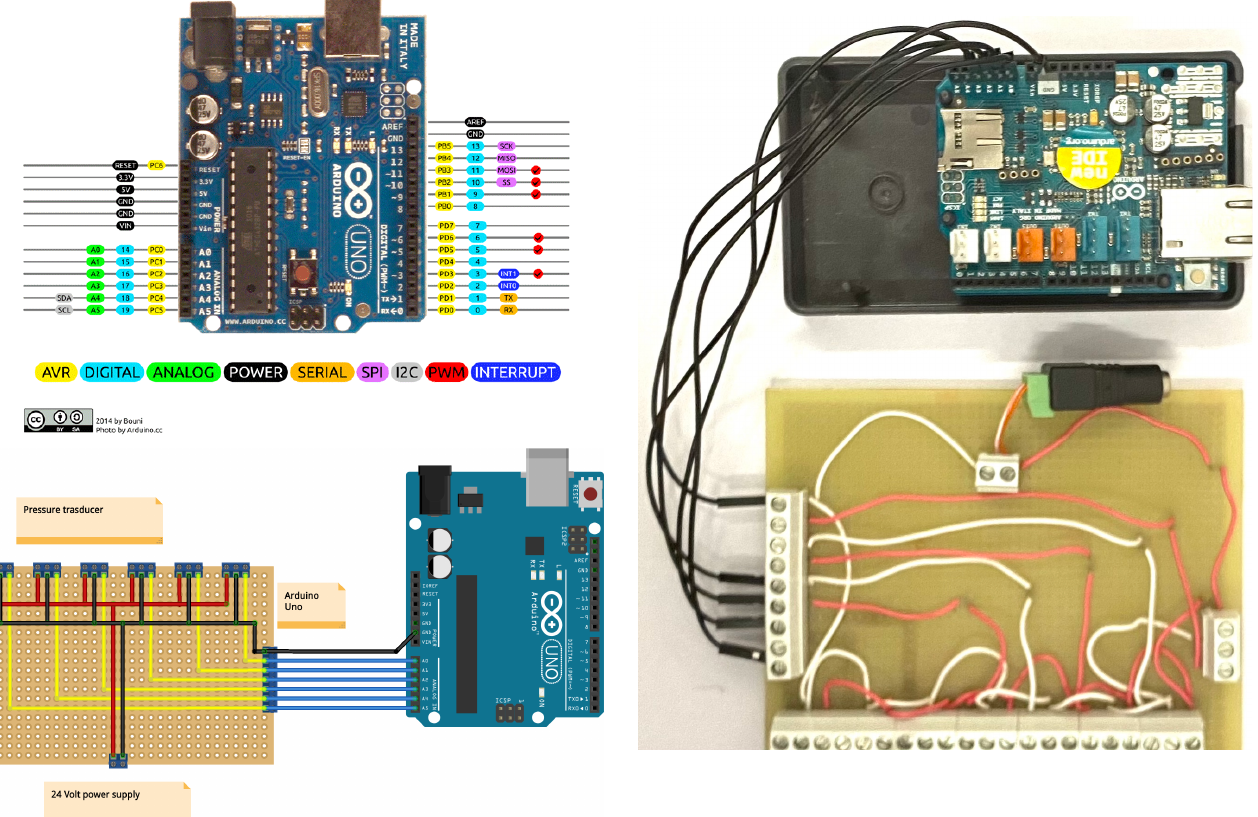
Figure 3. ( Left ) Panel: ( Top ): Arduino Uno pinout scheme. ( Bottom ): Prototype printed circuit board. ( Right ) Panel: Laboratory